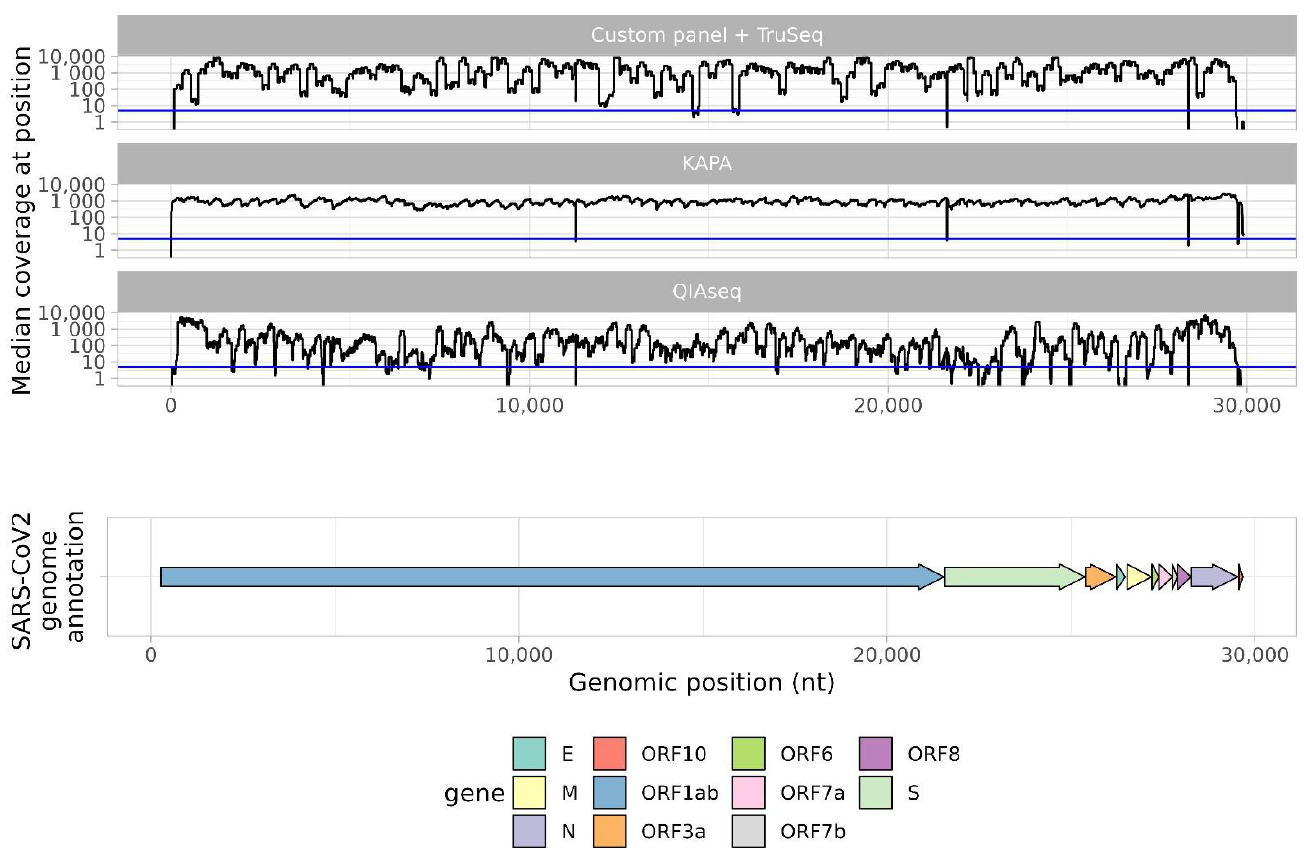
Figure 3. Median sequencing depth across the genome, depending on sample preparation method. The x -axis shows position in the SARS-CoV-2 genome and corresponding ORF. The y -axis shows median coverage (among 40 samples) by genomic position. The blue line represents a median coverage value of 5. A separate coverage graph is presented for each method.